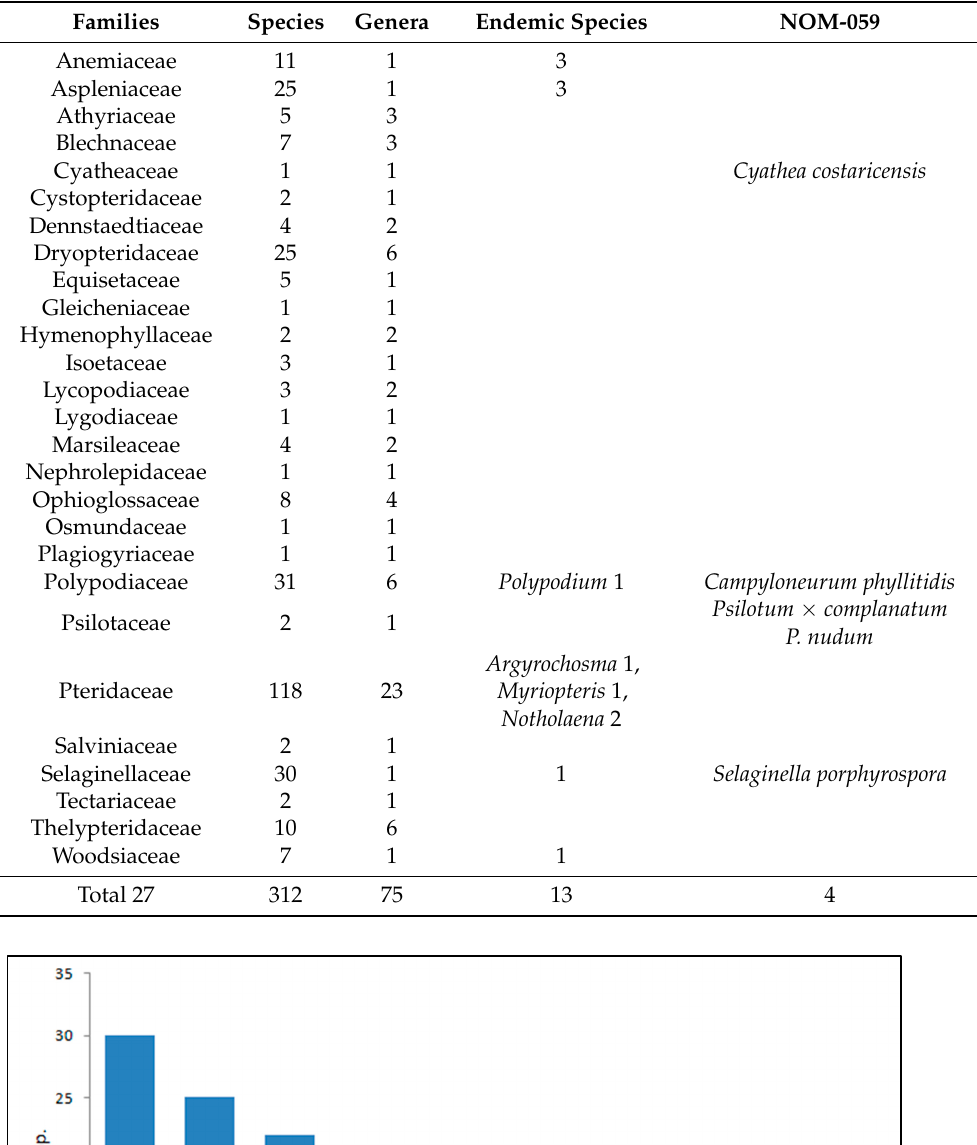
Table 1. Families of ferns and lycophytes represented in the SMOc. We recorded the number of species and genera in each family, the species endemic to the SMOc, and the species included in the Mexican Official Norm NOM-059-SEMARNAT-2010 [67].